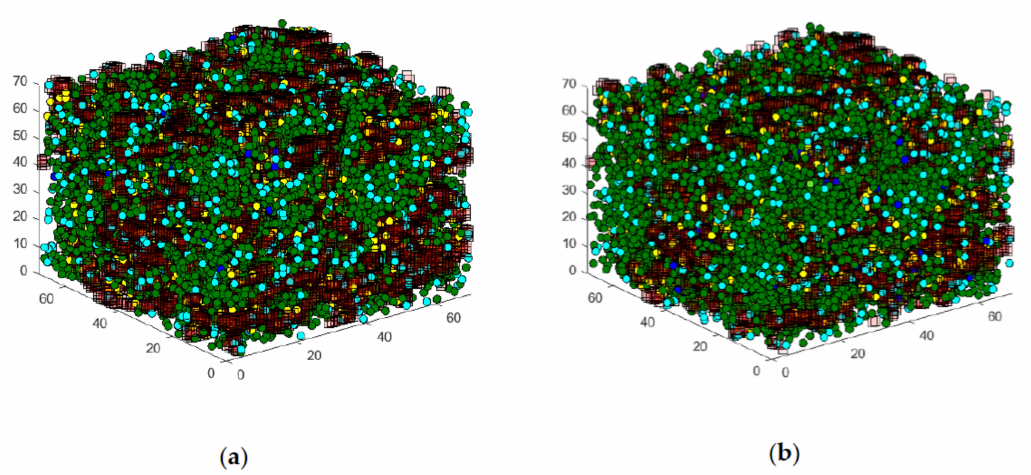
Figure 18. Graphical Cellular Automaton output of a configuration of the model under glucose stimulation, ( a )withreferencenetwork#1, ( b )withnetwork#4,